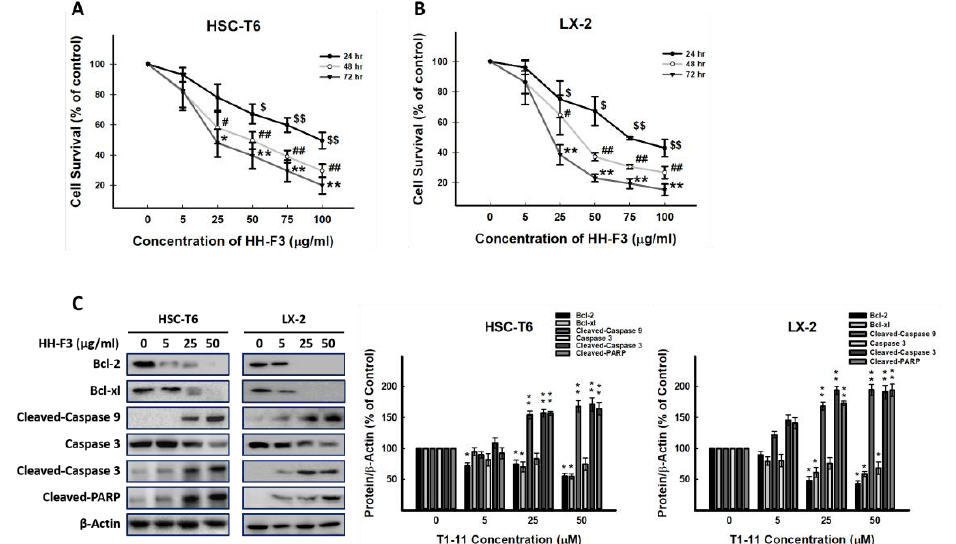
Figure 2. HH-F3 inhibits the growth of hepatic stellate cells via apoptosis. ( A ) HSC-T6 and ( B )